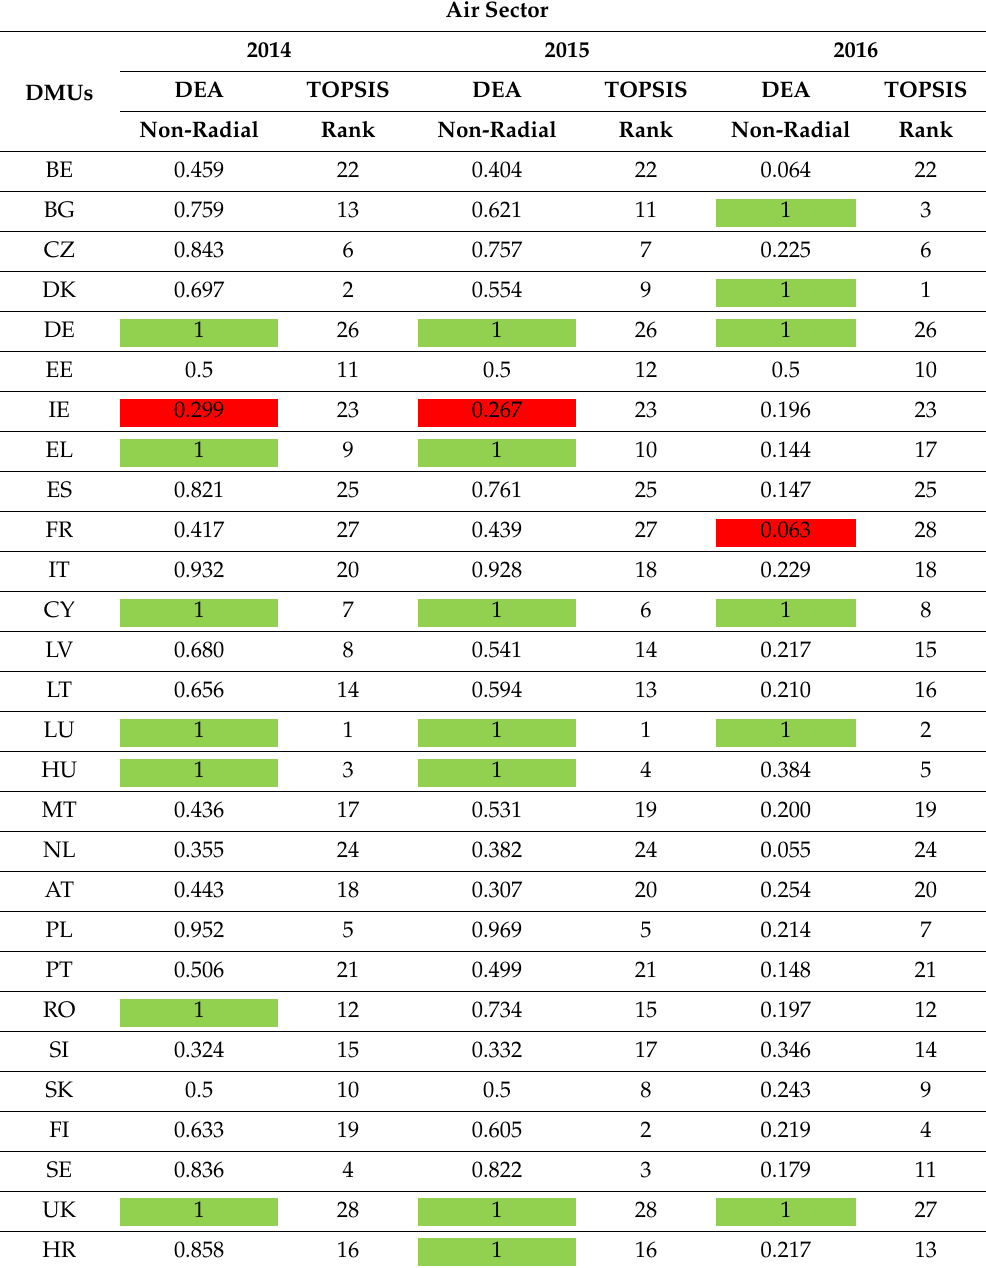
Green color: the best EEEI . Red color: the least EEEI